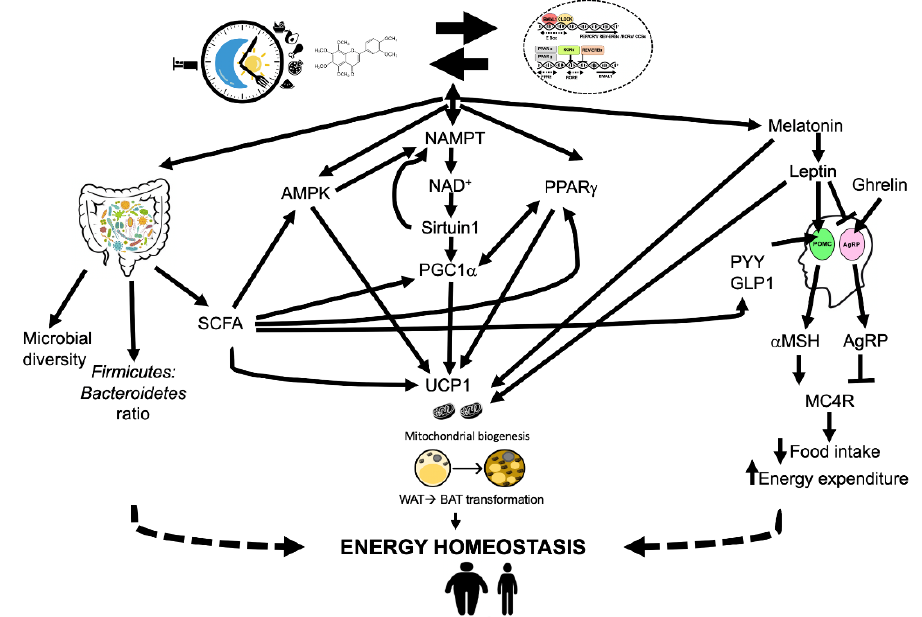
Figure 4. Mechanisms of chrononutrition: the bidirectional interactions between clock machinery, dietary polyphenols and meal times lead to rhythmic expression of various genes involved in sleep, energy balance, metabolism and regulation of gut microbiota. NAD, AMPK, SIRT1, SCFA, all derived from gut microbiota via PGC1a, lead to mitochondrial biogenesis and browning of white adipose tissue. MC4R pathway, via leptin, ghrelin, GLP1 and PYY, controls energy expenditure and satiety. Gut microbiota influenced by chrononutritional approaches also contributes to the overall energy homeostasis and BMI regulation. UCP1 (uncoupling protein 1) SCFA (short chain fatty acids), GLP1 (glucagon-like peptide-1), PYY (peptide YY), AgRP (agouti-related protein), POMC 9 (proopiomelanocortin ), α -MSH (melanocyte-stimulating hormone), MC4R (melanocortin receptor 4), AMPK (AMP-activated protein kinase), NAD + (nicotinamide adenine dinucleotide) , PPARγ (peroxisome proliferator- activated receptor γ), NAMPT (nicotinamide phosphoribosyltransferase), NAD + (nicotinamide adenine dinucleotide), AMPK (AMP-activated protein kinase), CCGs (clock- controlled genes), SIRT1 (sirtuin 1), PGC1 α (PPARγ coactivator 1α).